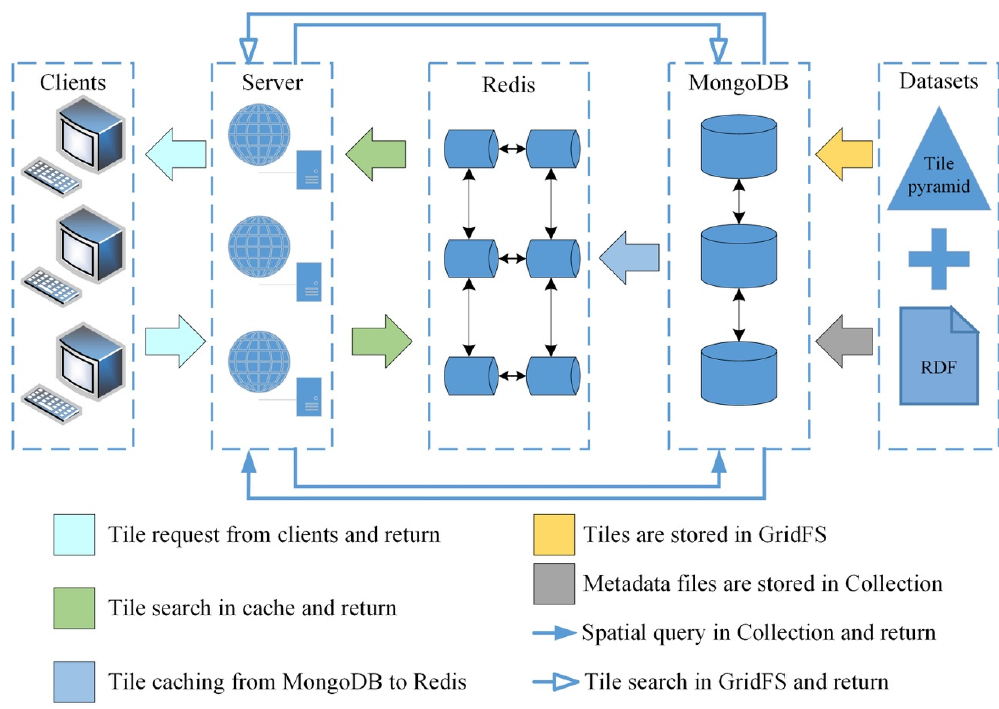
Figure 6. The entire tile request process from the clients and the response in the servers.